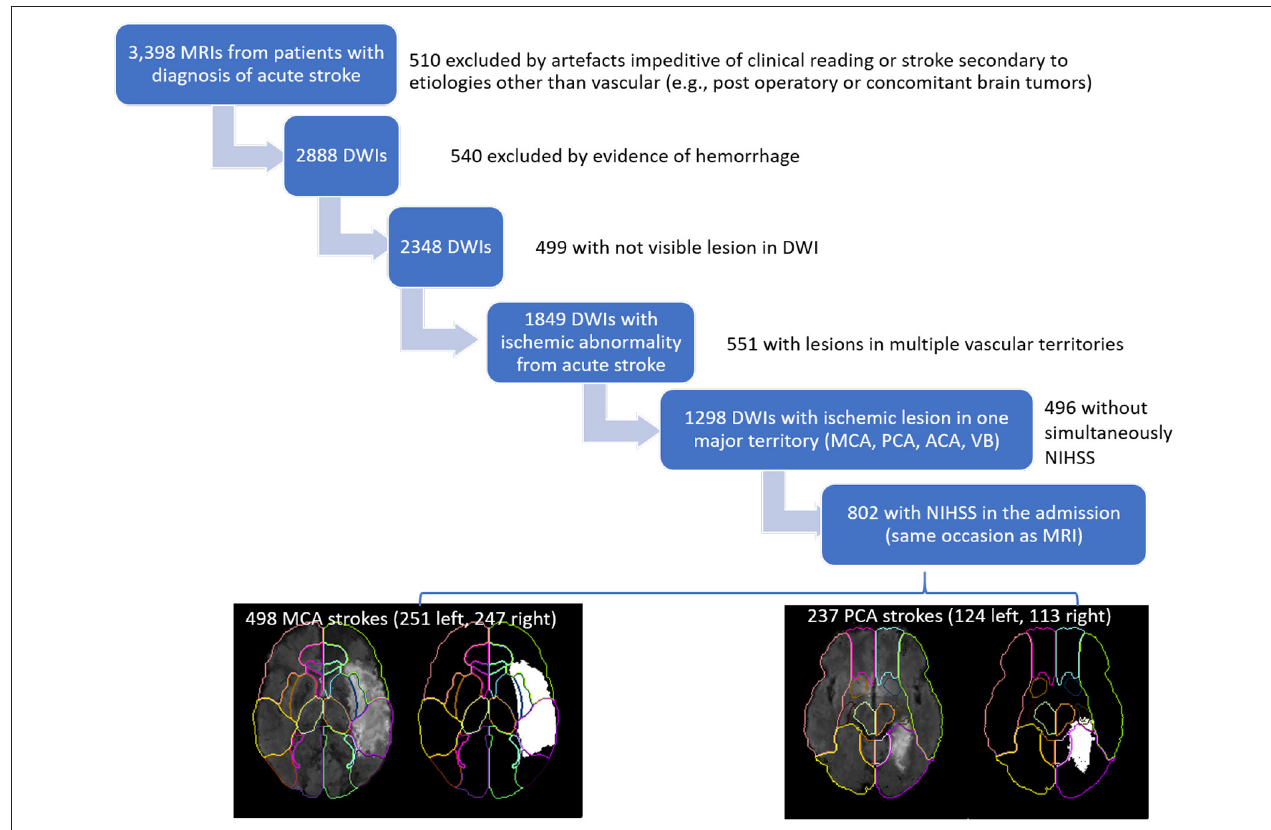
FIGURE 1 | Flowchart of data